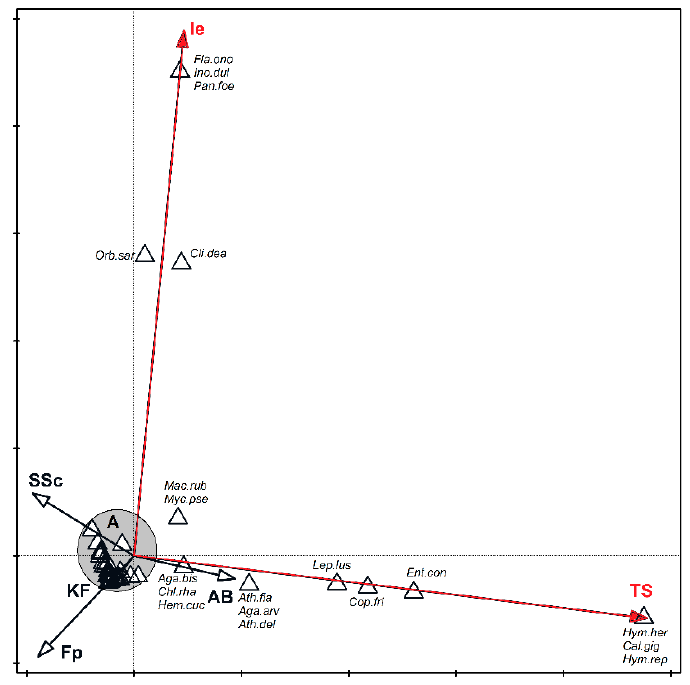
Figure 6. Canonical correspondence analysis (CCA) for the dataset on the occurrence of macrofungal species in studied plant associations. Vectors of variables which are significant for diversity are marked in red. They explain collectively 14.5% of the total variability. Abbreviations of species names are as follows: Aga.arv , Agaricus arvensis ; Aga.bis , Agaricus bisporus ; Ath.del , Atheniella delectabilis